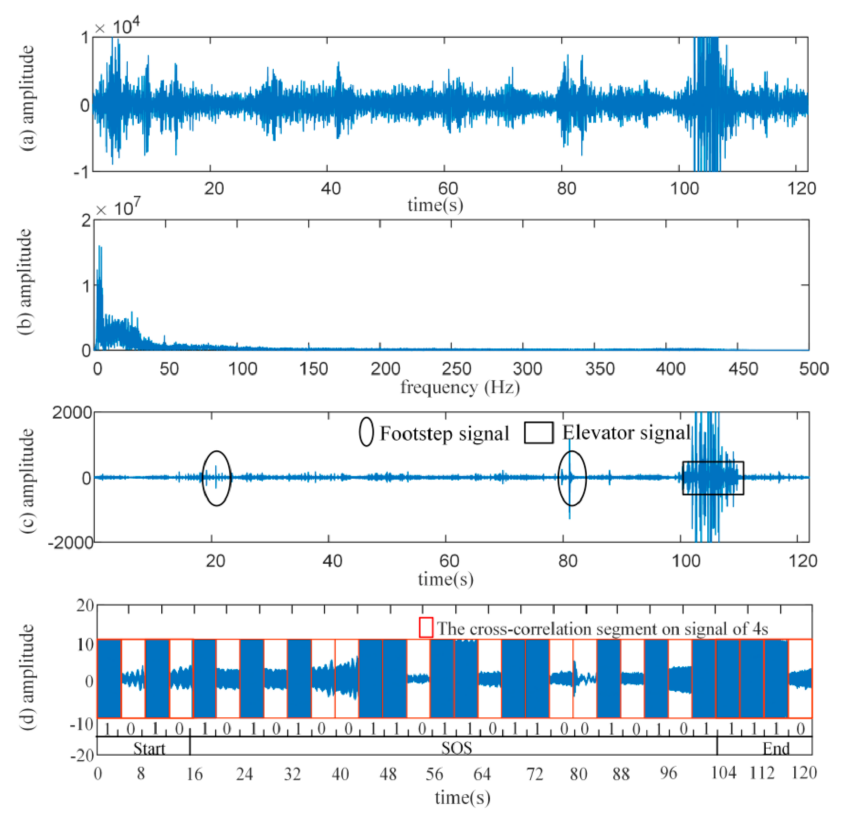
Figure 6. The collected signal at 60 m; ( a ) The original data at 60 m; ( b )The spectral analysis of the original data; ( c ) The target signal extraction with a band-pass filter; ( d ) The target signal extraction with the segmented correlation